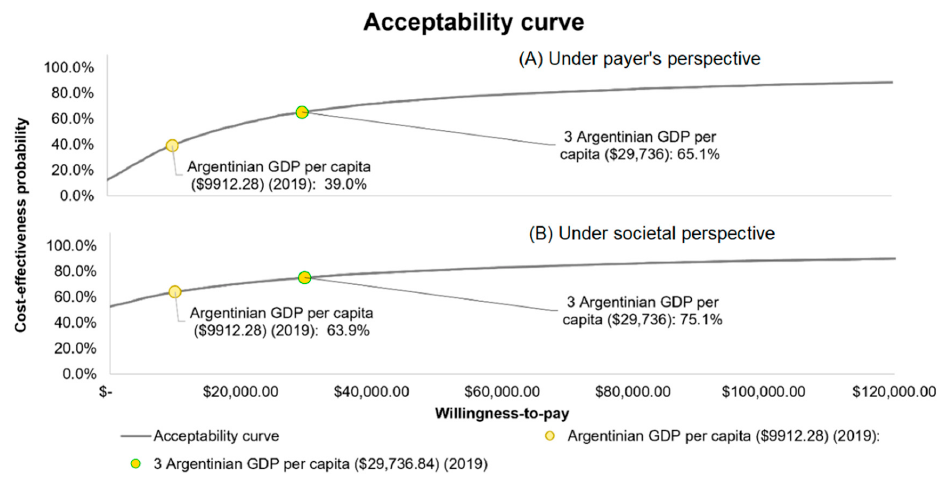
Figure 6. Cost-effectiveness acceptability curve of QIVc vs.